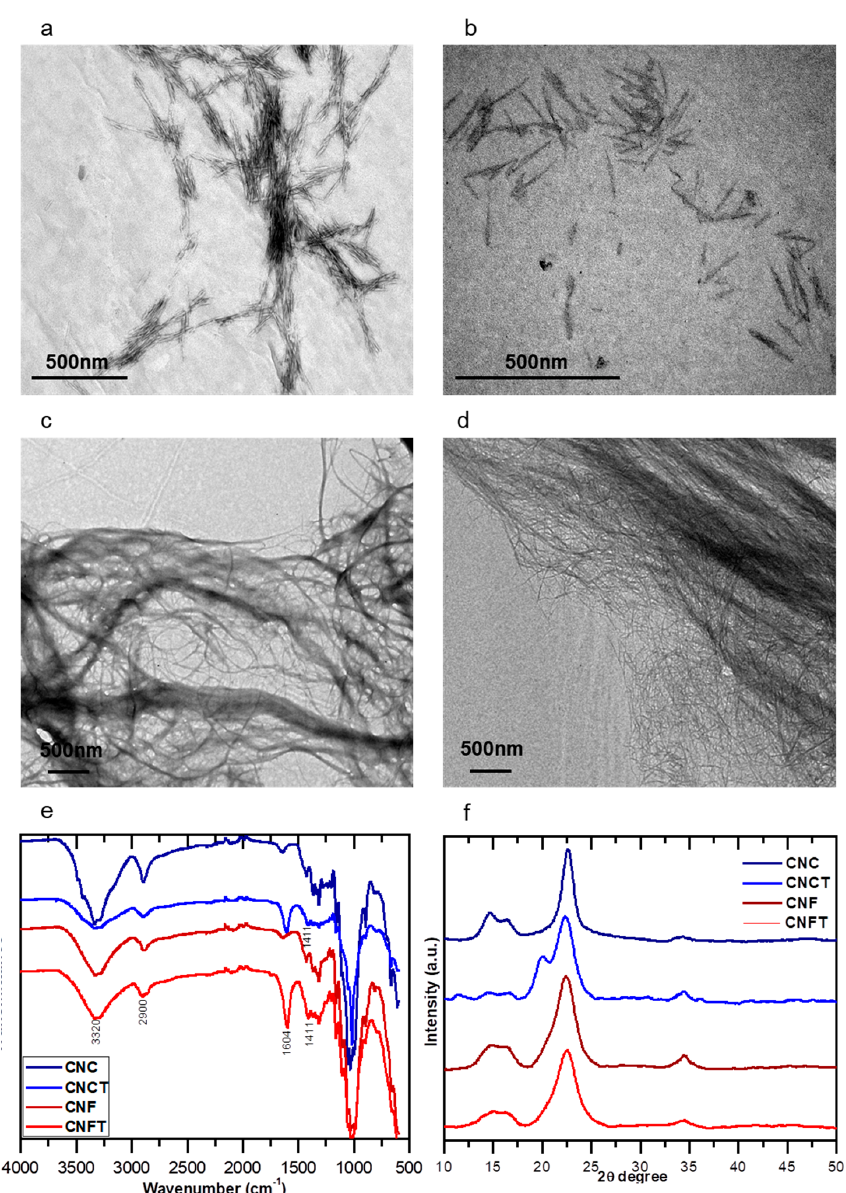
Figure 1. Morphological and structural characteristics of the unmodified and oxidized nanocellulose samples. Transmission electron micrographs (TEM) of: ( a ) cellulose nanocrystals (CNCs); ( b ) TEMPO-oxidized cellulose nanocrystals (CNCTs); ( c ) cellulose nanofibers (CNFs); and ( d ) TEMPO-oxidized cellulose nanofibers (CNFT). FTIR spectra of CNC, CNCT, CNF and CNFT ( e ) and ( f ) X-ray diffraction (XRD) patterns of CNC, CNCT, CNF, and CNFT.